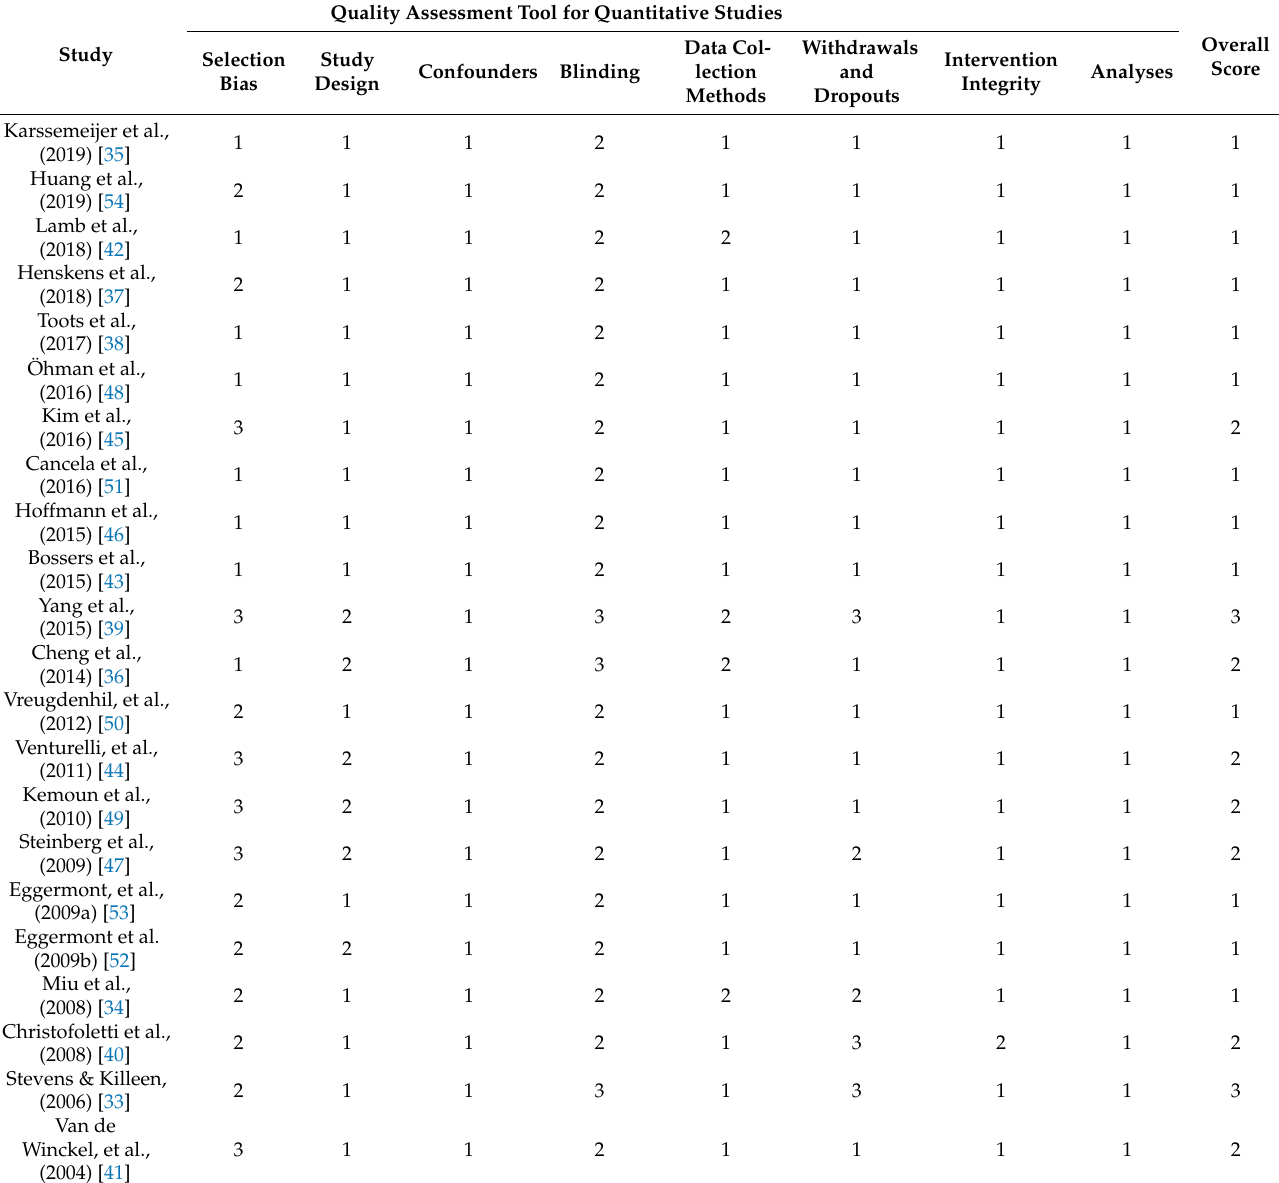
Table 3. Methodological quality assessment “Effective Public Health Practice Project (EPHPP) Quality Assessment Tool for Quantitative